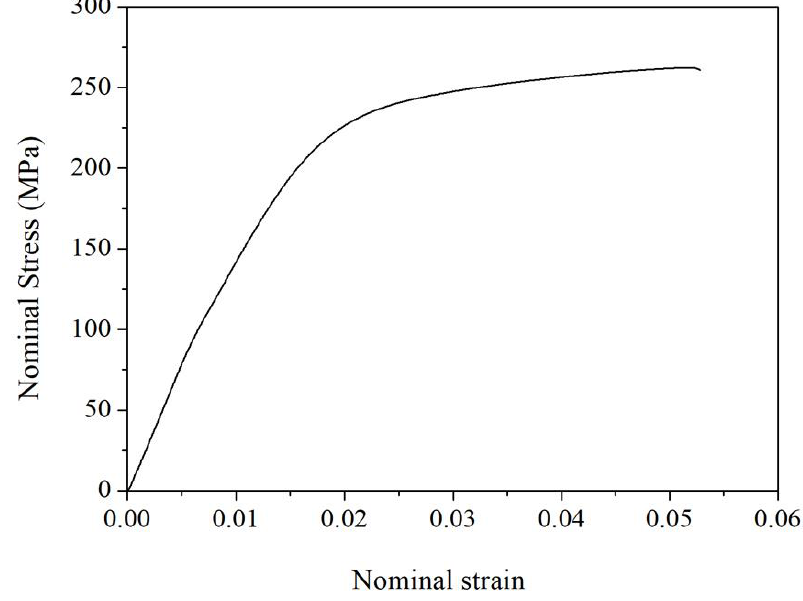
Figure 8. Size distribution of the Al 2 Y particles in the as-extruded YA65 alloy. Materials 2018 , 11 , x FOR PEER REVIEW